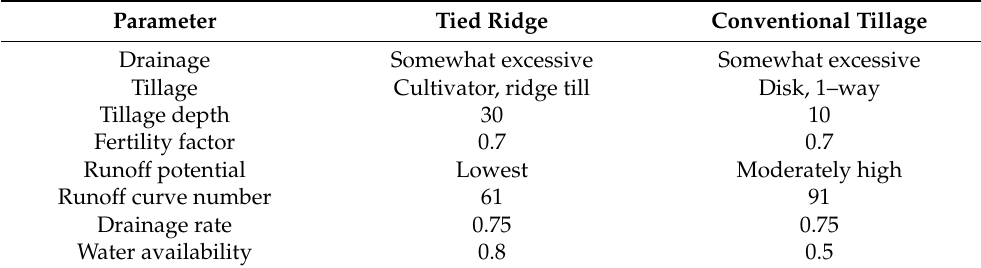
Table 2. Definition of CSM–CERES parameters for SWC